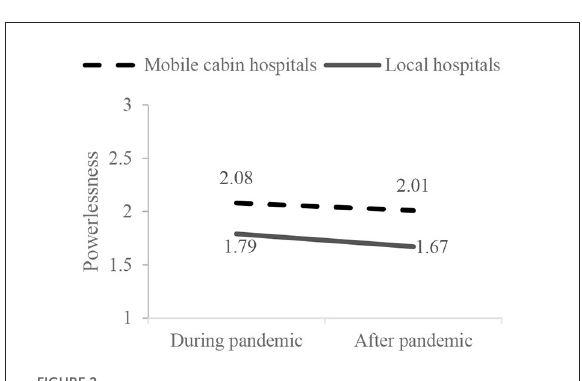
FIGURE2 Interactive effects on the medical staff’s